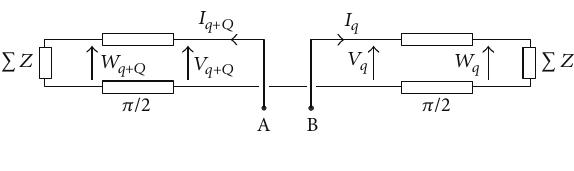
Figure 5: Input node of the feeding